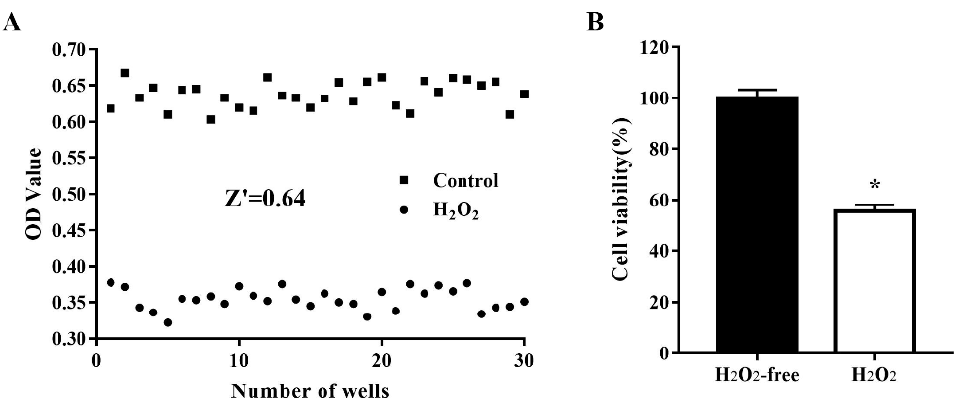
Figure 2. Reproducibility of the oxidative damage model in an automated 96-well assay format. IPEC-J2 cells were seeded in 96-well plates at a density of 8000 cells/well. Thirty H 2 O 2 -free wells were used as a positive control and 30 H 2 O 2 -treated wells were used as a negative control. The cells were treated, and not treated, with 1000 µ M H 2 O 2 at 37 ◦ C for 4 h after which cell viability was assessed using the CCK-8 assay. The data are presented as optical density values of 30 individual wells ( A ) and as the mean ± standard error of the mean (SEM) of cell viability in 30 wells ( B ). * p < 0.05 vs. H 2 O 2 -free wells.